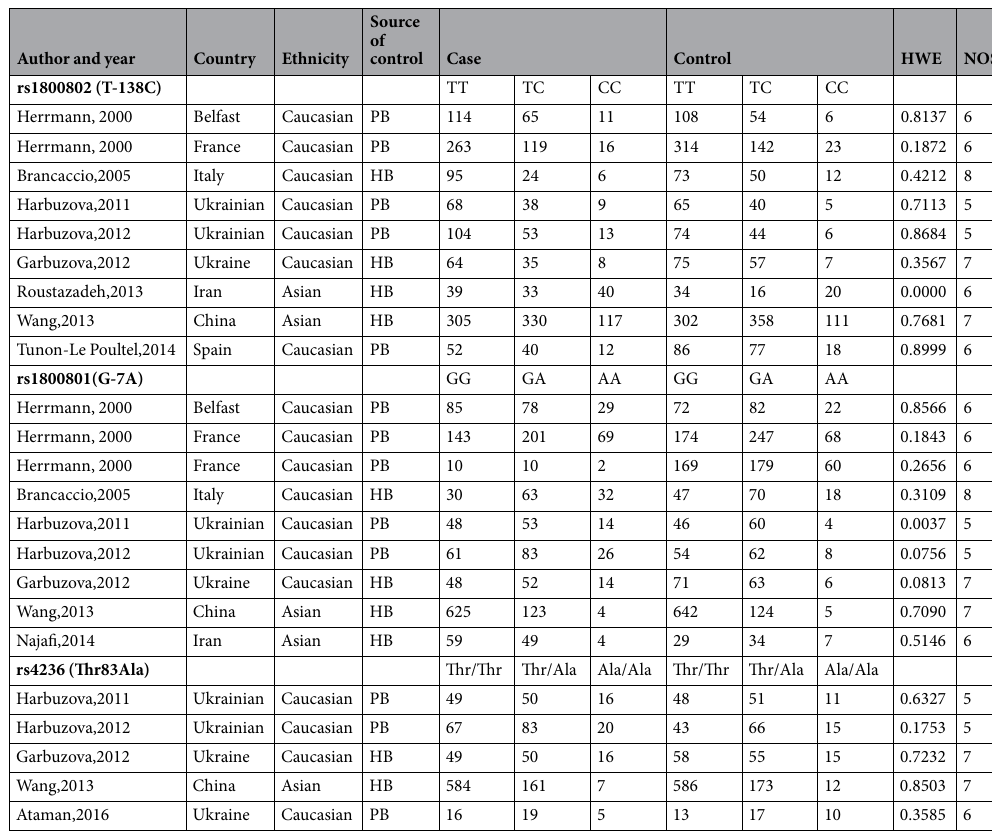
Table 1. Characteristics of studies included in this meta-analysis. HWE, Hardy-Weinberg equilibrium; NOS, Newcastle Ottawa Scale; PB, population based; HB — hospital